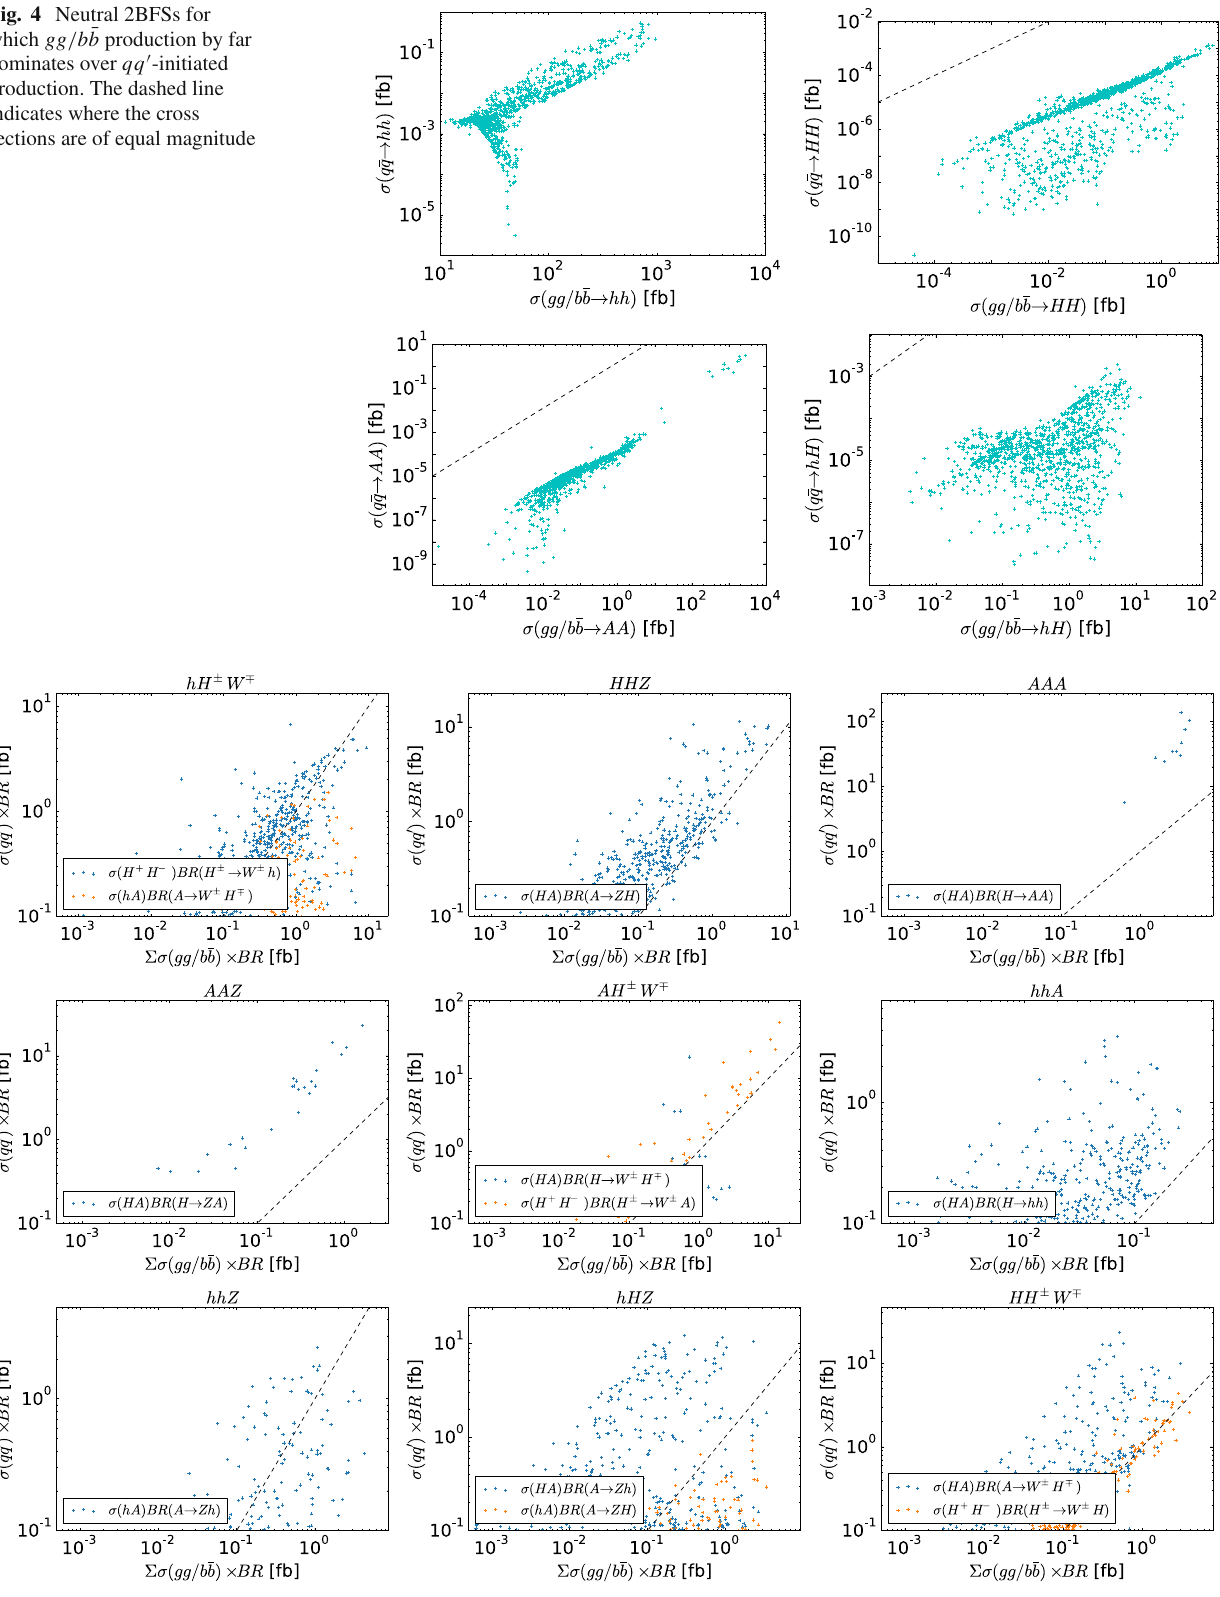
Fig. 5 Comparison of the cross sections for the qq (cid:2) -initiated subprocesses and their gg / bb -initiated counterparts, for selected neutral 3BFSs. The dashed line indicates where the cross sections are of equal